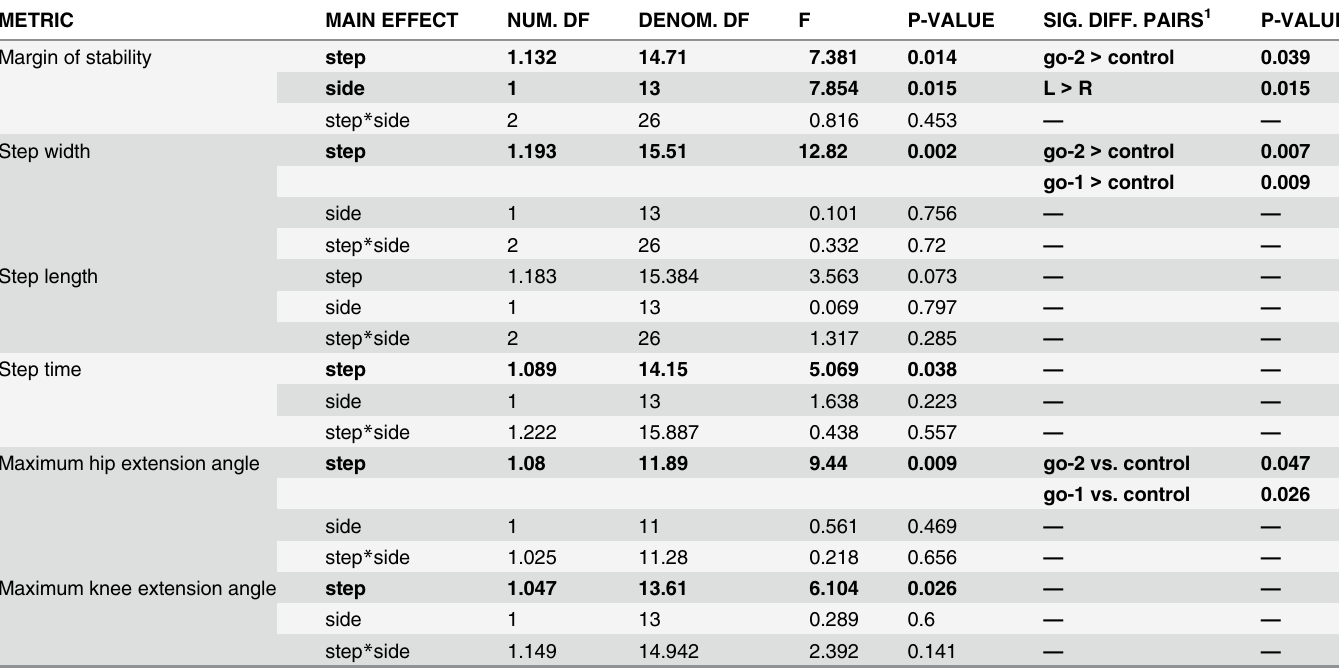
Table 4. Unknown target direction statistical